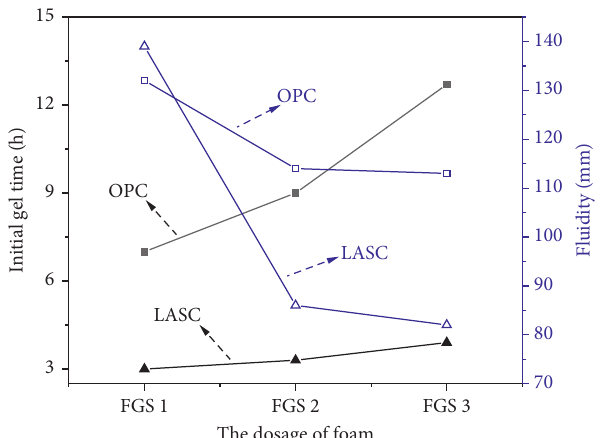
Figure 12: Foam dosage and density of the filling material. FGS 0 is , which is the material density after solidification of ρ 0